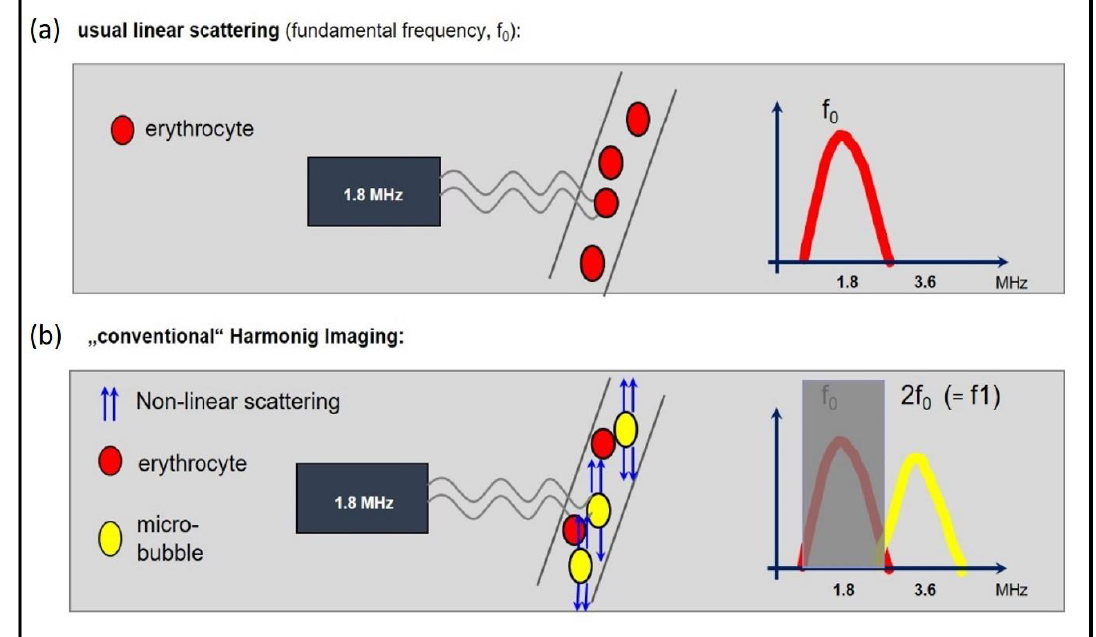
Figure 4. The basic principle of harmonic imaging. ( a ) When an ultrasound wave passes through tissue, the predominantly linear scattering of the erythrocytes results in a frequency, which is reflected back to the probe, which is equal to the transmitted frequency (here: fundamental frequency of 1.8 MHz). ( b ) “ Harmonic imaging ” due to non-linear scattering of the microbubbles: the resonance frequency of the microbubbles is typically a multiple of the transmitted (or fundamental) frequency. The harmonic frequencies are sent back to the probe, where they are used to create the image. Specifically, the second harmonic frequency (2f0) is used. The fundamental component is filtered out, so that that the received frequency of 3.6 MHz is two-fold higher than the transmitted frequency of 1.8